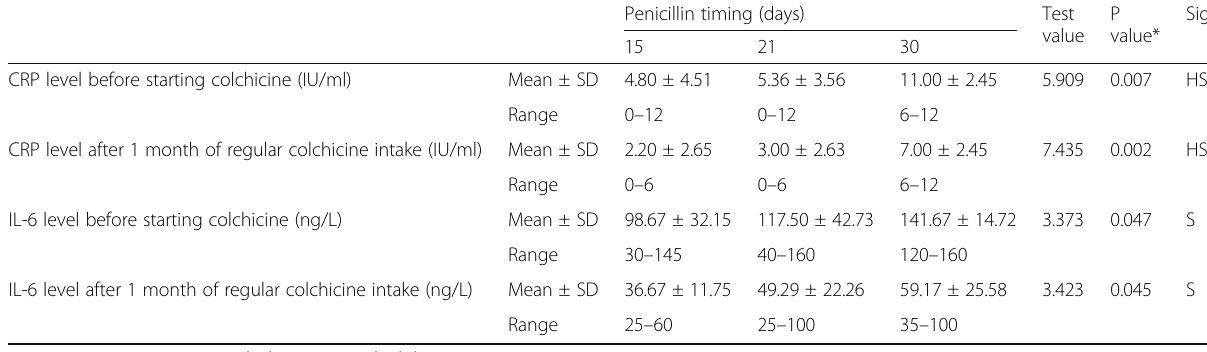
Table 4 Effect of colchicine on the serum IL-6 and CRP in relation to different penicillin regimens